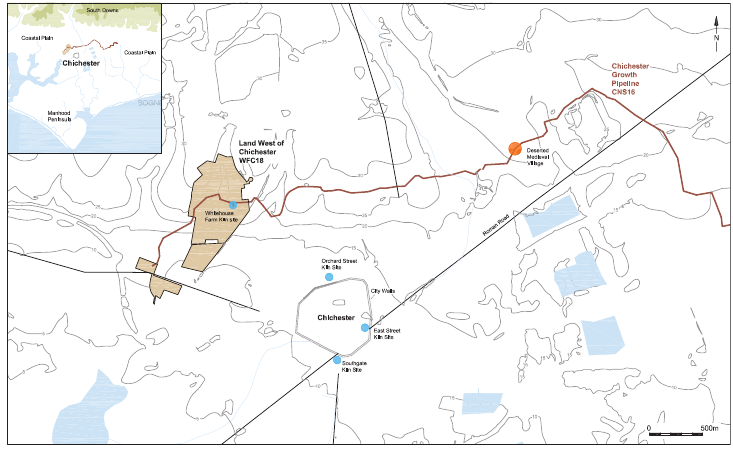
Figure 1 Site location plan (Source: Archaeology